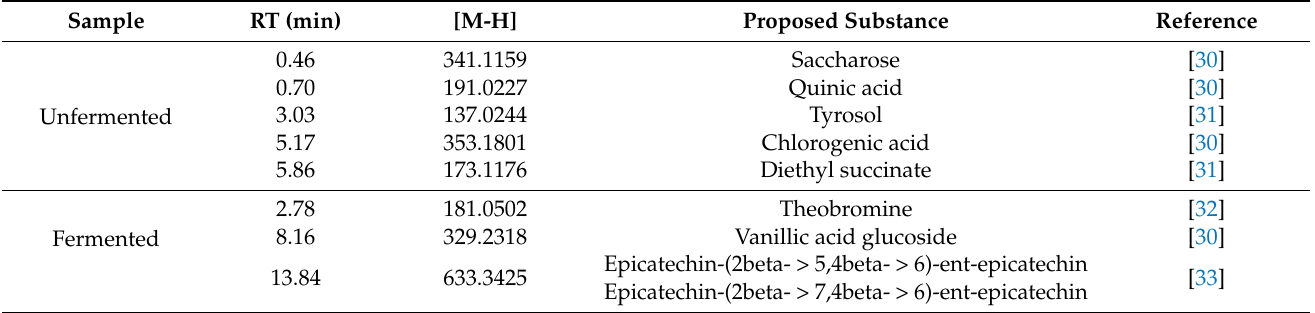
Figure 2. Comparative chromatograms of the ethyl acetate phase of cupuaçu juice ( Theobroma grandiflorum ) with and without fermentation by Lacticaseibacillus rhamnosus ATCC 9595. Based on the analysis of molecular ion peaks ( m/z ) in the obtained chromatogram and in comparison with the literature data, some metabolites differentially present in each sample were identified (Table 4). Saccharose, quinic acid, tyrosol, chlorogenic acid, and diethyl succinate were only identified in unfermented juice, while Theobromine, vanillic acid glucoside, and epicatechin-(2beta- > 5,4beta- > 6)-ent-epicatechin (or epicatechin-(2beta- > 7,4beta- > 6)-ent-epicatechin) were only detected in L. rhamnosus -fermented juice. Table 4. Identification of substances differentially present in the ethyl acetate phase of cupuaçu juice ( Theobroma grandiflorum ), with and without fermentation by Lacticaseibacillus rhamnosus ATCC 9595.